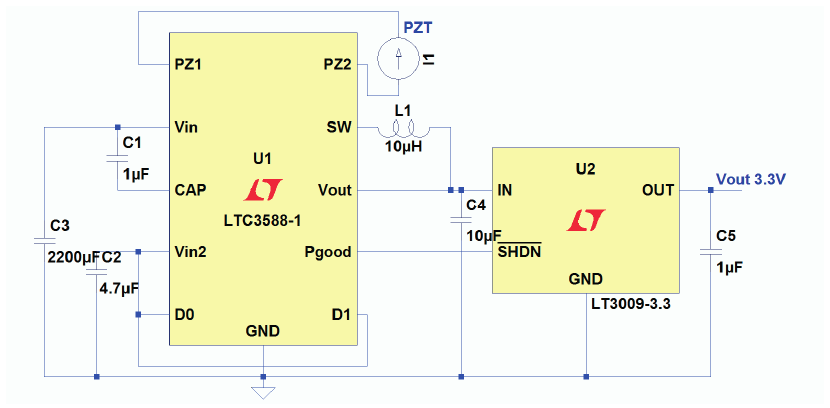
Figure 8. The power management